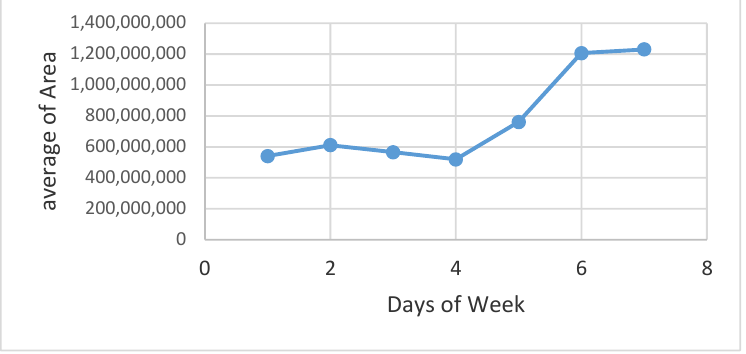
Figure 2. The relation between days of the week and users' activity space